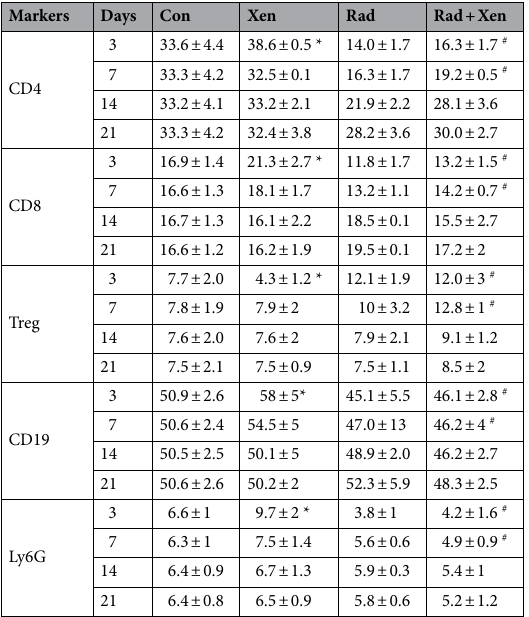
Table 4. Flow cytometry assay on 3, 7, 14, and 21 days after gamma radiation. Con: control, Xen: cell injection group, Rad: gamma radiation group, and Xen + Rad: gamma radiation plus cell injection group. * P ≤ 0.05 compared to the control group. # P ≤ 0.05 compared to the Xen group.